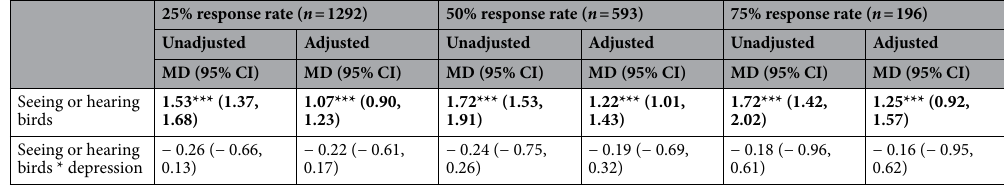
Table 2. Associations between seeing or hearing birds and subjective mental wellbeing and interactions with depression. Mean difference (MD) and 95% confidence intervals (CI) represent the mean difference in momentary mental wellbeing per category increase compared to the reference group. Statistically significant associations (p < 0.05) are highlighted in bold. Analyses were explored as crude associations and after adjusting for age, gender, ethnicity, education, occupation, whether a participant could see trees, plants, and see or hear water. *p < 0.05. **p < 0.01. ***p <